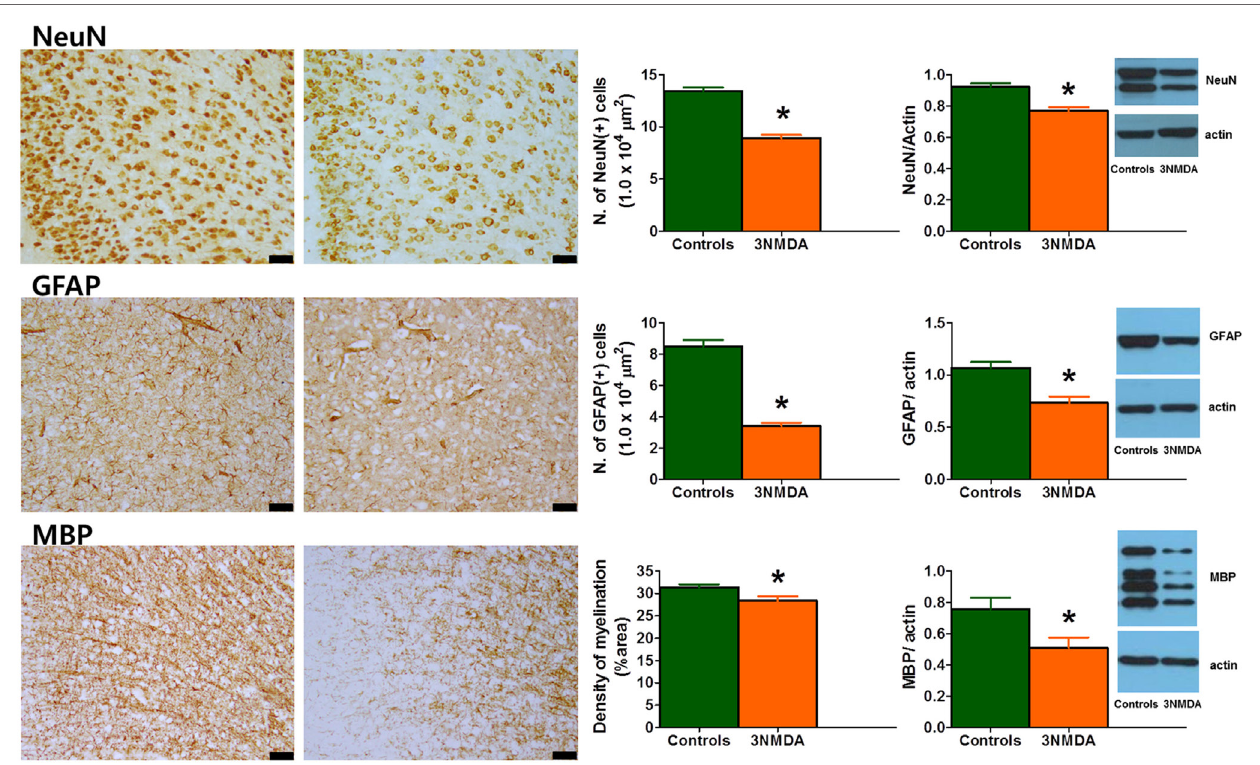
Figure 6 | Glial fibrillary acidic protein (GFAP), myelin basic protein (MBP), and neuronal nuclei (NeuN) expression in the cingulate cortex during the juvenile period. (Left) Immunohistochemical staining of the cingulate cortex on P35 revealed decreased expression of GFAP, MBP, and NeuN in rats with three bouts of N -methyl- d - aspartate (NMDA)-induced spasms. The scale bars indicate 50 µm. (Right) Western blot analysis of the rat cortex on P35 showed significantly decreased expression of GFAP, MBP, and NeuN after multiple bouts of NMDA-induced spasms (* p < 0.05, Mann–Whitney U